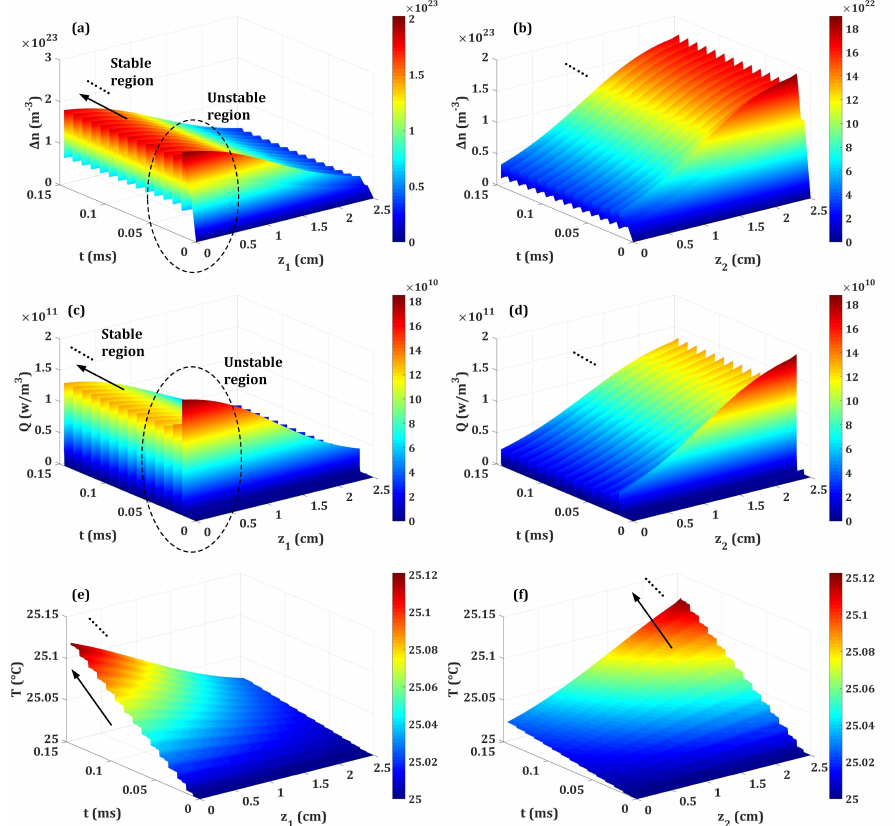
Figure 4. The temporal evolution of ( a ) population inversion in Xtal 1; ( b ) population inversion in Xtal 2; ( c ) heat generation in Xtal 1; ( d ) heat generation in Xtal 2; ( e ) temperature distribution in Xtal 1; and ( f ) temperature distribution in Xtal 2 along the z -axis at 100 kHz Q-switched